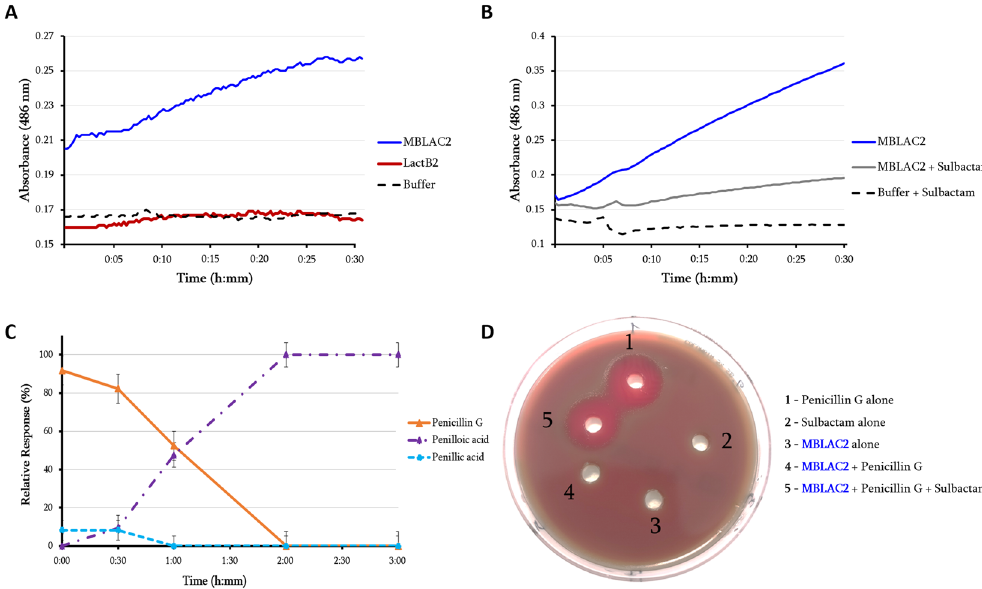
Figure 2. Characterization of two hMBL enzymes. ( A ) Spectrophotometric assay of nitrocefin degradation in the presence of MBLAC2 and LactB2 enzymes, showing the real hydrolysis activity of MBLAC2, whereas LactB2 exhibits no activity on this substrate; ( B ) monitoring nitrocefin degradation over time in the presence and absence of sulbactam (1 µ g/ml). ( C ) LC/MS average relative response of the screened metabolite compounds of penicillin G in the presence of the MBLAC2 hMBL enzyme monitored for three hours. Penicillin G (in orange) refers to the intact form of the antibiotic and penilloic acid (in purple) and penillic acid (in light blue) refer to the penicillin G metabolites. Penicillin G in PBS did not show any degradation to any metabolite (data not shown). ( D ) Microbiological test of the mixture of penicillin G (0.1 µ g/ml) with the human β -lactamase enzyme (MBLAC2) in the presence and absence of sulbactam on the highly penicillin-susceptible and sulbactam-resistant Pneumococcus strain. The halo around holes 1 and 5 reveals the growth inhibition of the Pneumococcus strain. The absence of this halo around holes 2, 3, and 4 indicates that no effect of the mixture on Pneumococcus growth was